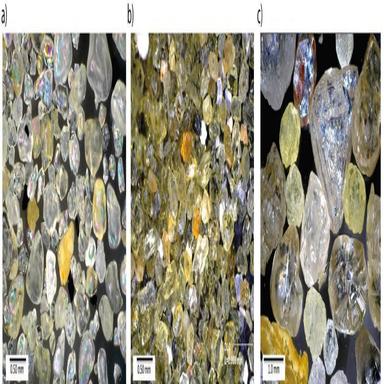
Sand obtained from various sources: (a) rounded quartz grains from Copa Cabana, Brazil, (b) faceted olivine grains from Hanauma, Oahu, Hawaii, (c) variously-shaped and sized industrial grade diamonds.